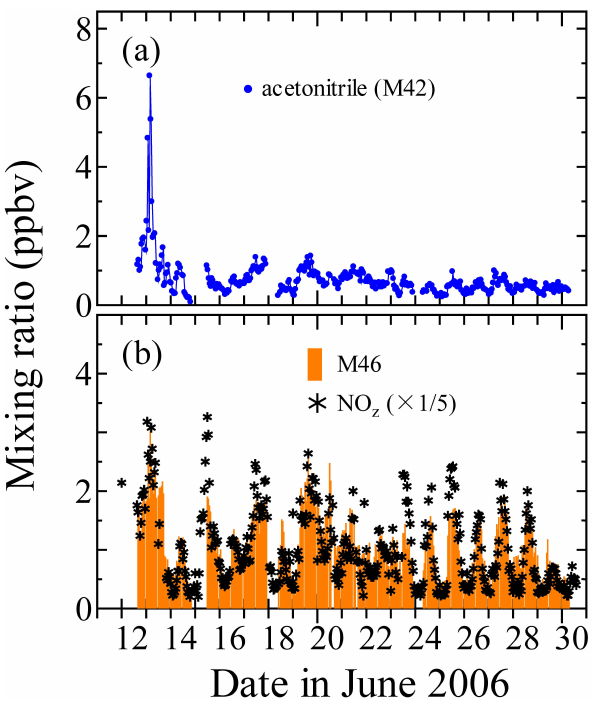
Fig. 6. Temporal variations of mixing ratios for nitrogen-containing VOCs: (a) acetonitrile, (b) M46 and NO z (=NO y − NO x ). Hourly averaged PTR-MS and NO z data are shown. Fig. 7. (a) Scatterplots of M46 versus M78 observed during the